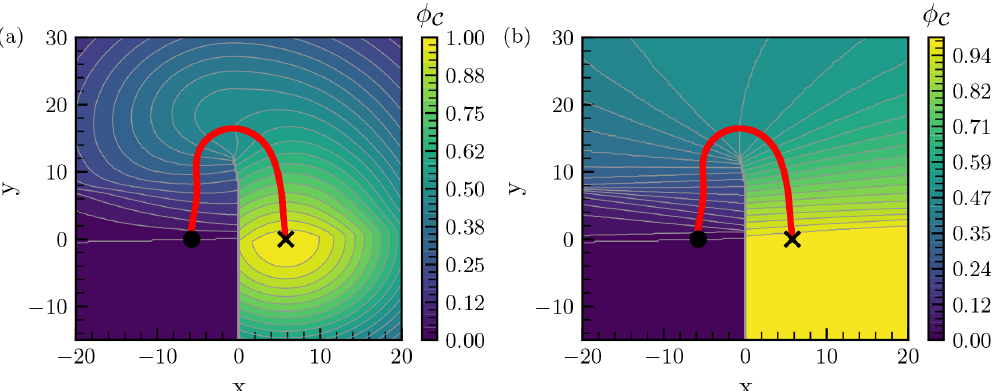
Figure 7. (a) Contour levels of the score function φ C defined in Eq. (16) associated with the estimated transition path C shown in Fig. 6 and with decay length d 0 = 20. (b) Same figure for d 0 =